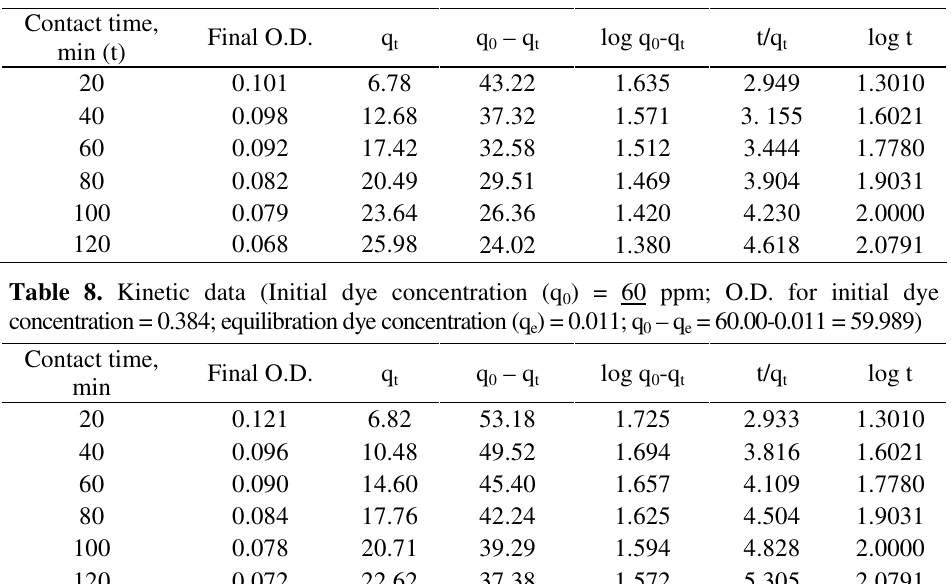
) = 50 ppm; O.D. for initial dye 0 ) = 0.010; q – q = 50.00 - 0.010 = 49.990) e 0 e